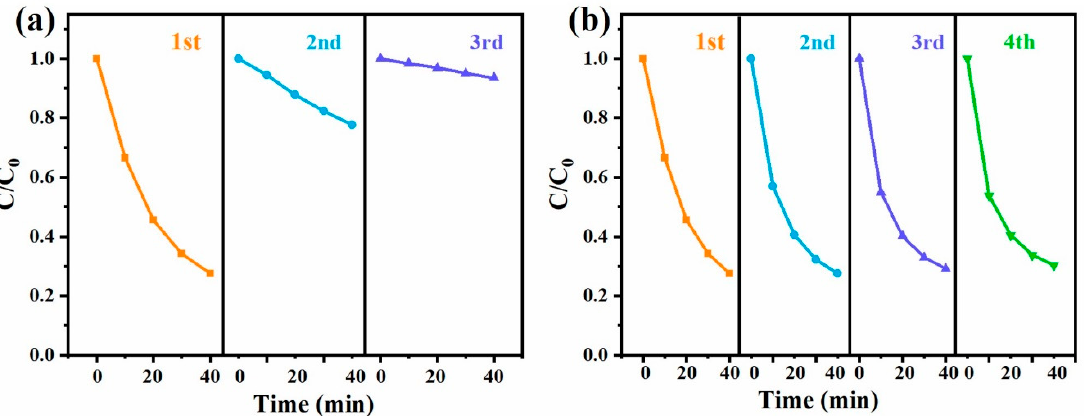
Figure 8. Reusability of CNT-O-H without regeneration ( a ) and with regeneration ( b ) of heat treat- ment (General conditions: 25 ◦ C, natural pH, 0.2 g/L CNT-O-H, 0.4 g/L PDS, 50 mg/L TC).